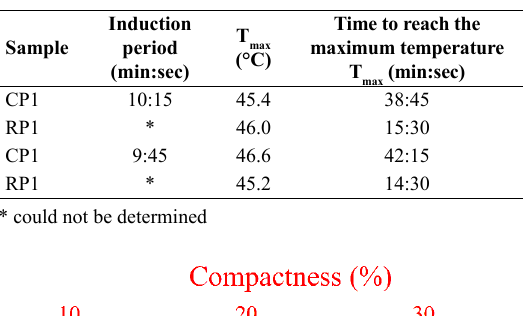
Table 7. Estimation of the induction period, the maximum temperature reached in the temperature kinetics test, and the elapsed time to reach the maximum temperature.